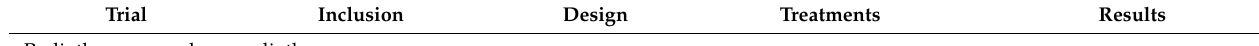
Table 1. Key Completed